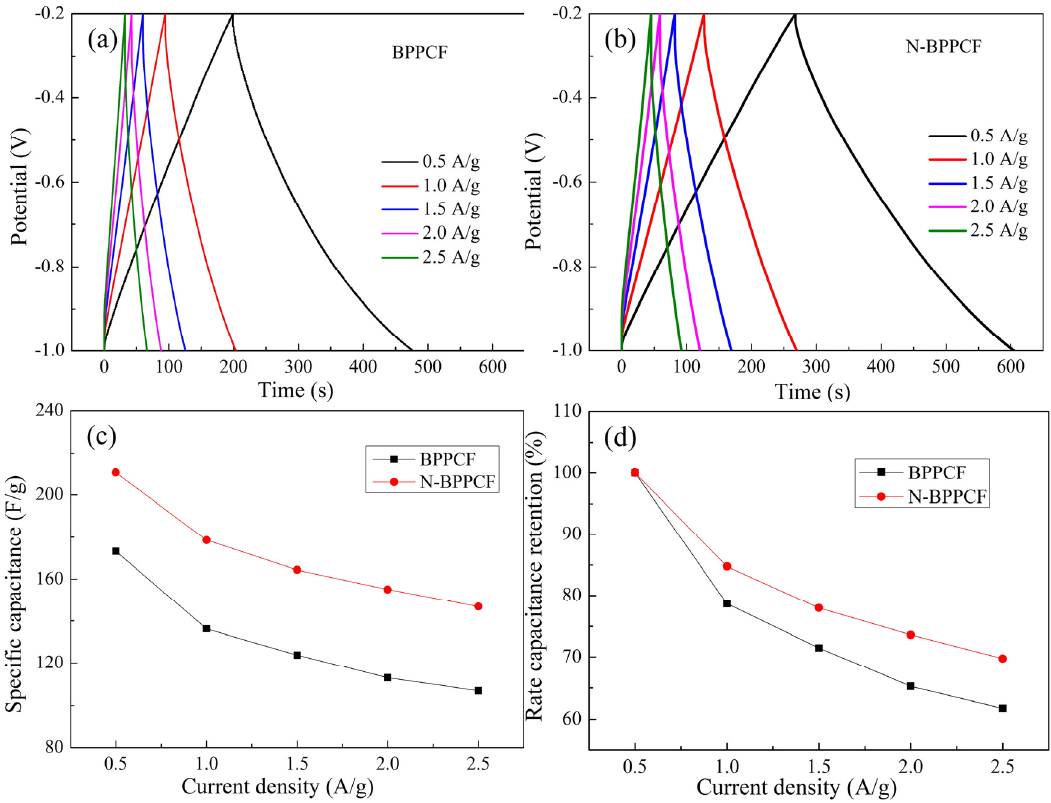
Figure 6. Galvanostatic charge/discharge (GCD) curves for ( a ) BPPCF and ( b ) N-BPPCF in 6 M KOH at various current densities. ( c ) Specific capacitance and ( d ) the corresponding rate capacitance retention of BPPCF and N-BPPCF.